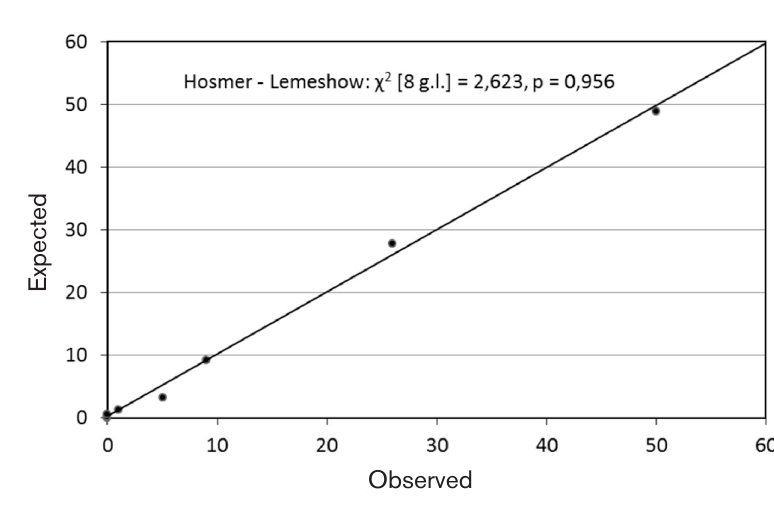
Fig. 1 - Risk-prediction model. Observed vs. expected values of risk deciles.